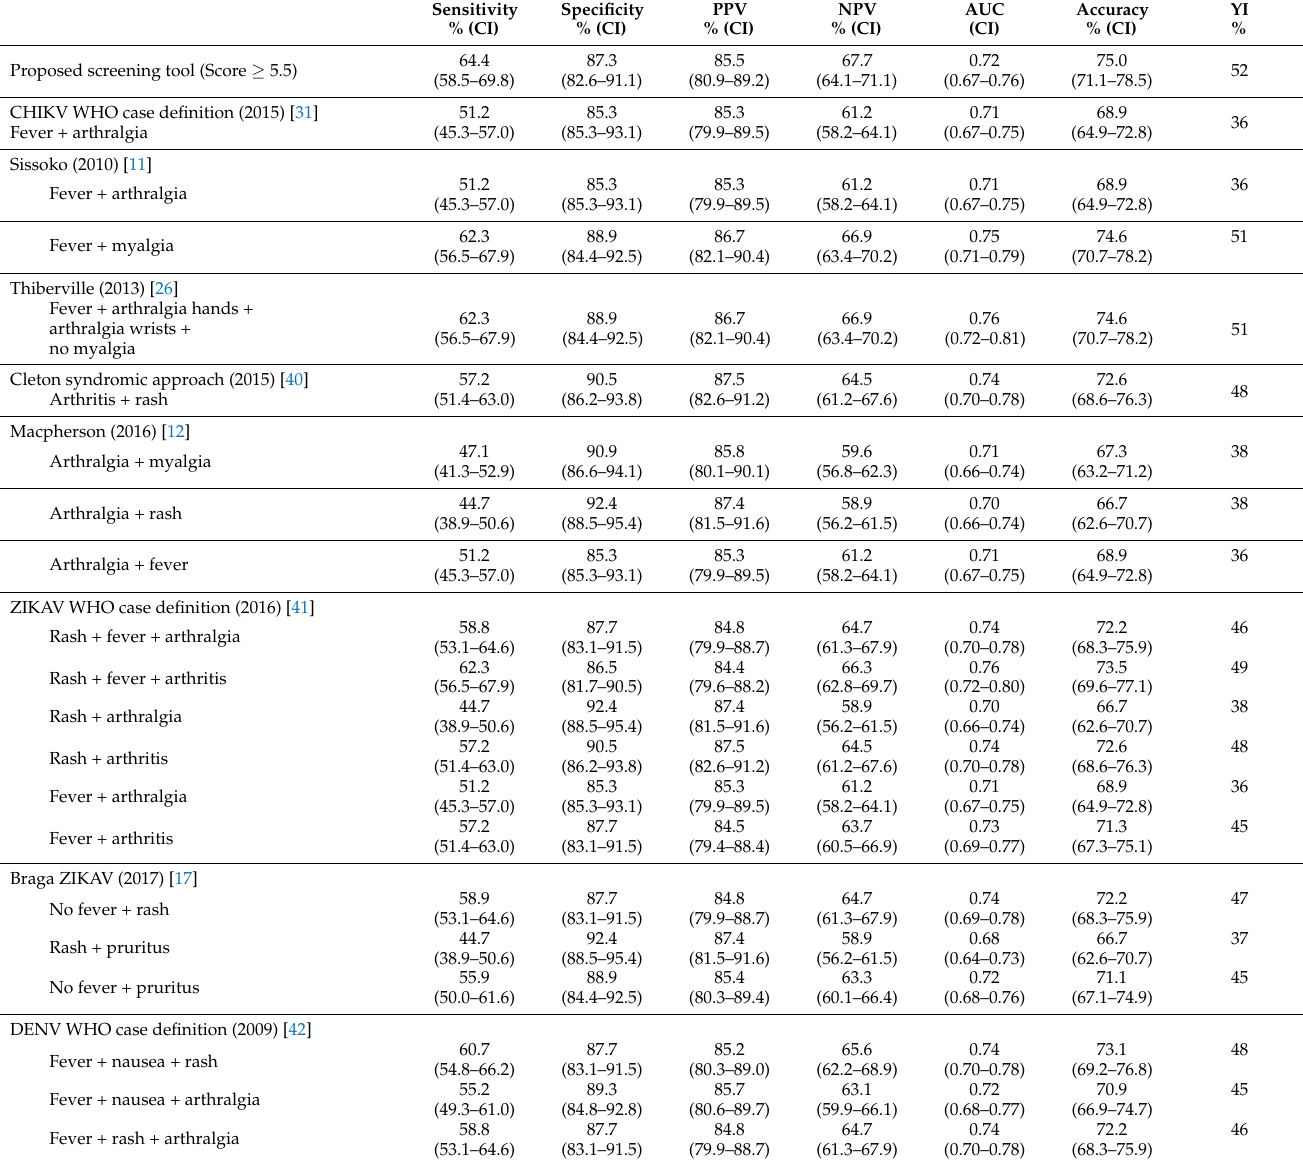
Table 5. Performance of different diagnostic tools in our confirmed CHIKV infected